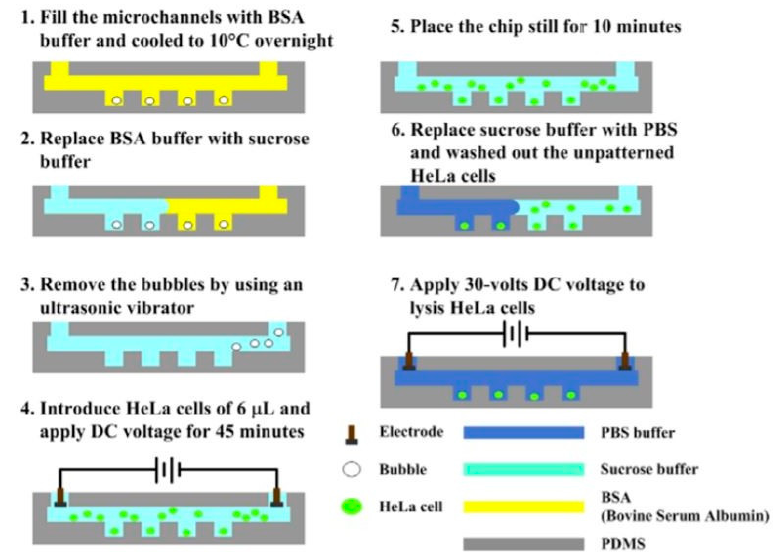
Figure 18. Experimental procedures for cell patterning utilized in [69].